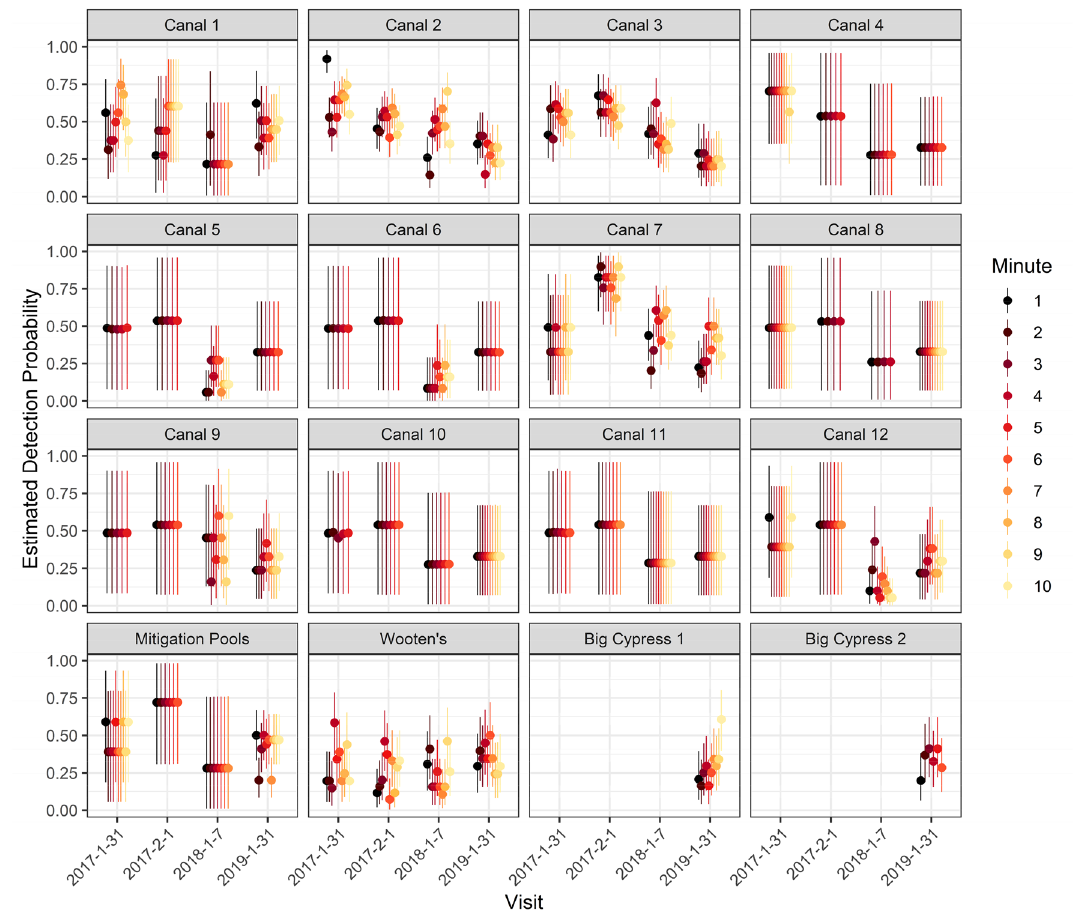
Figure 5. Estimates of the probability of detection for 1-min intervals for 10 min by site, date, and min. Dots indicate means (point estimates) and lines the 95% credible